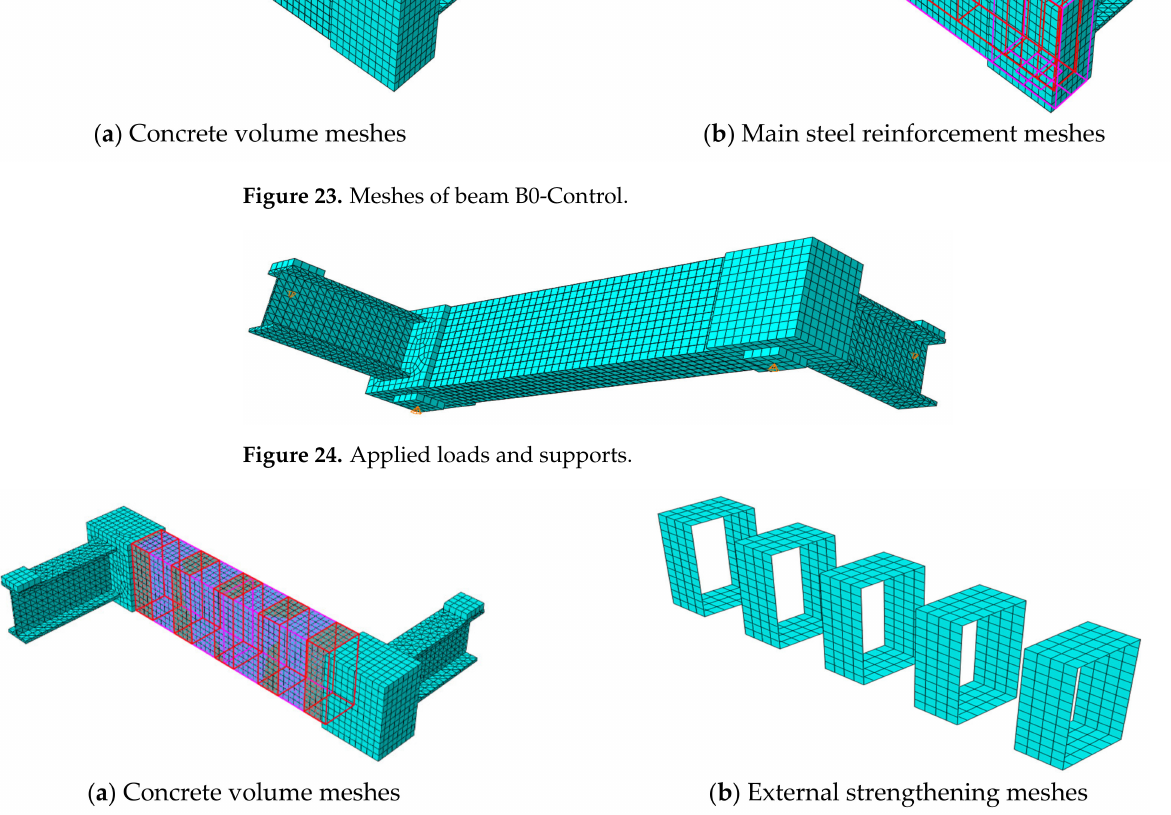
Figure 25. Meshes of beam B1-AS